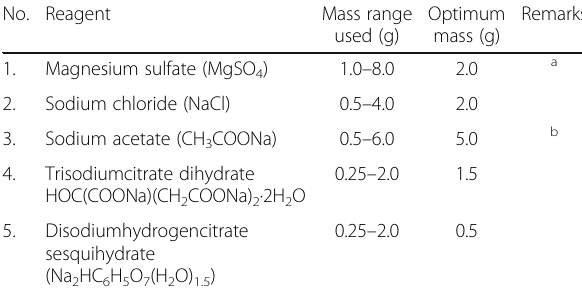
Table 1 Effect of mass of different reagent on various QuEChERS methods